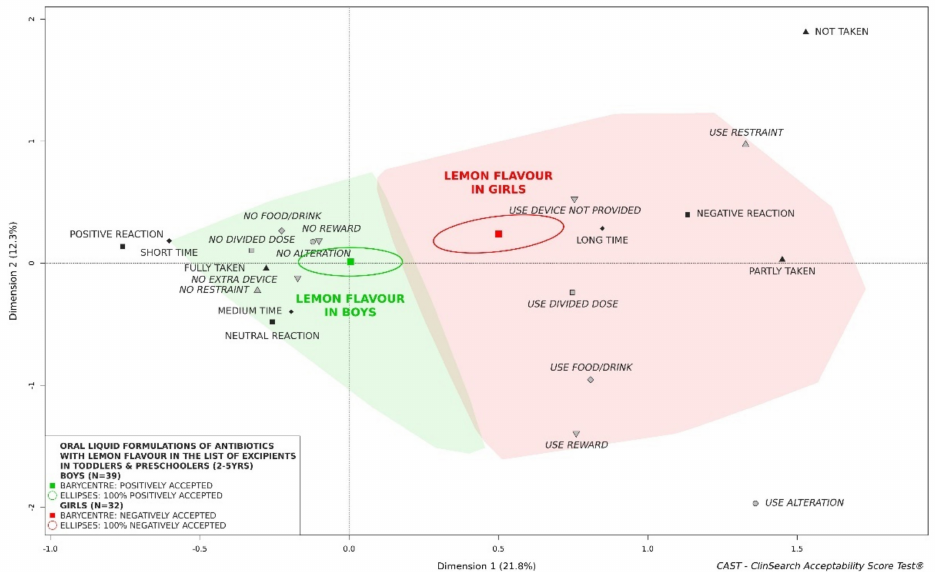
Figure 8. Acceptability of oral liquid formulations of antibiotics with lemon flavor in the list of excipients in toddlers and preschoolers depending on sex of